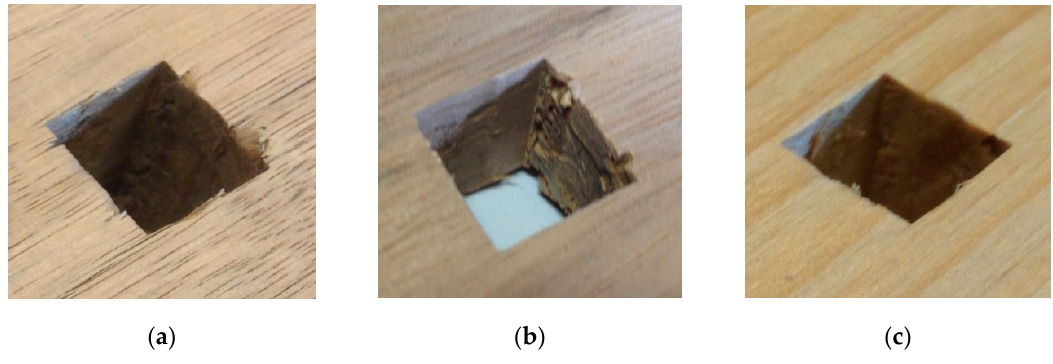
Figure 10. Examples of E. nitens ( a ) and E. globulus ( b ) with grades of G5 (very poor), and P. radiata ( c )